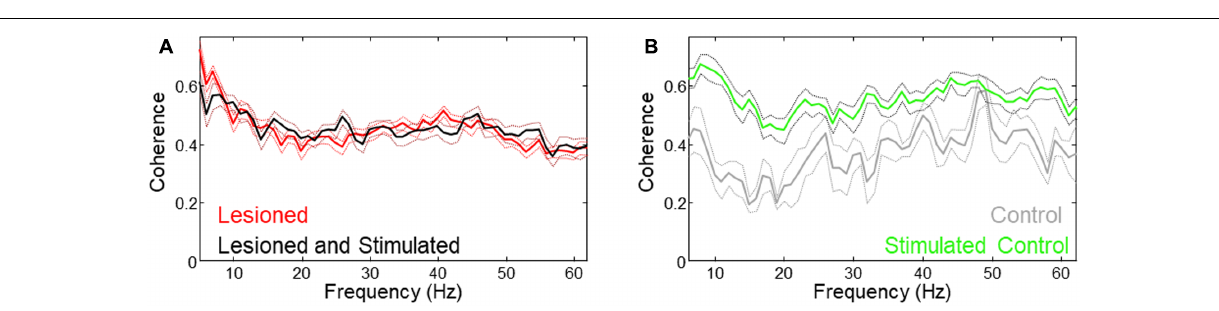
FIGURE 7 | Different coherence changes occurred with stimulation in lesioned vs. unlesioned mice. (A) Low frequency coherence was reduced in lesioned mice during stimulation. (B) Coherence was increased in unlesioned control during